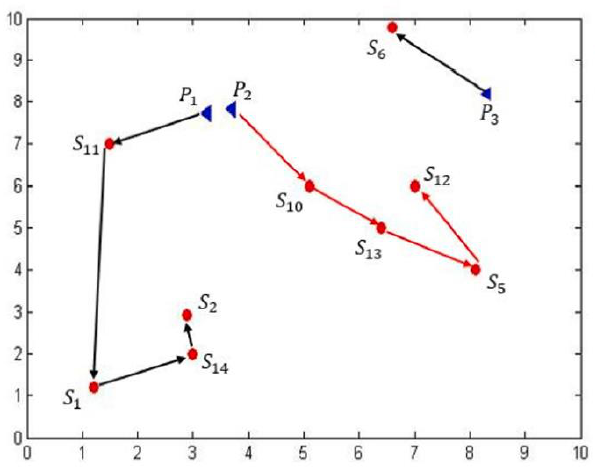
Figure 6. UAVs flight path chart considering cost and efficiency. Reprinted with permission from ref. [42]. Published by Elsevier B.V. Copyright © 2020 Elsevier Ltd. All rights reserved.